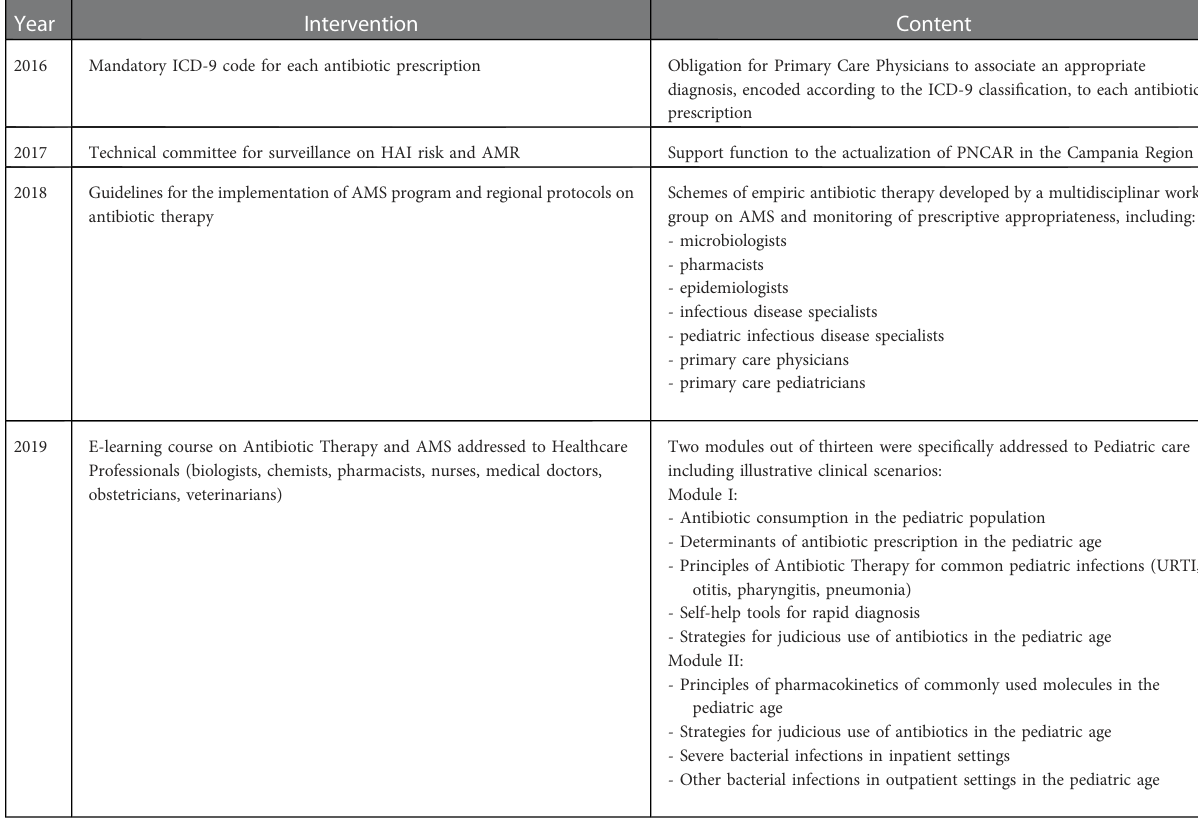
TABLE 1 Summary of regional antimicrobial stewardship